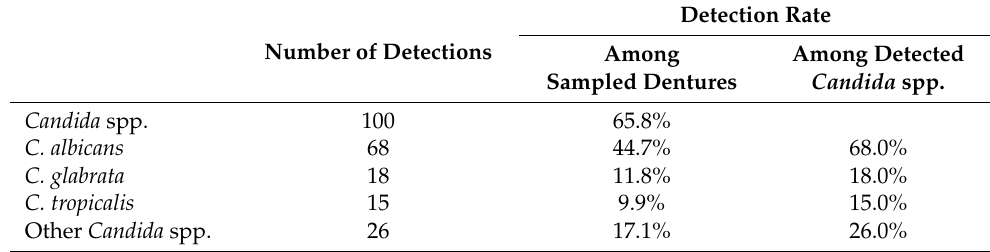
Table 2. Detection rates of Candida spp. on dentures.